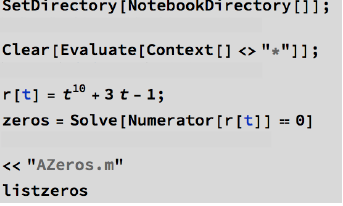
input of a rational function r to compute its zeros and locate them (Figure 42).